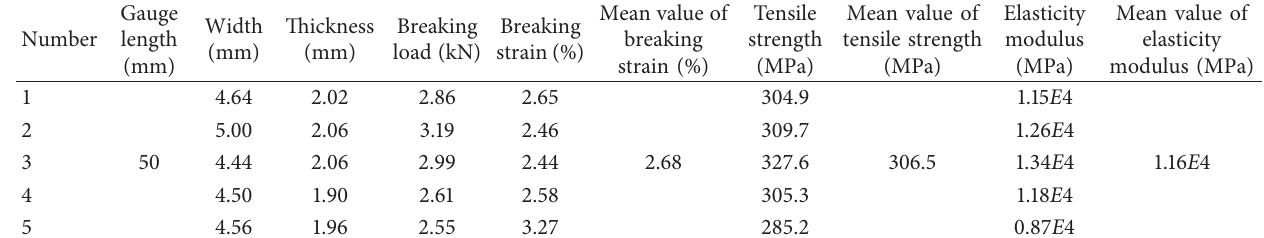
Table 5: Tensile strength and elastic modulus of bamboo.